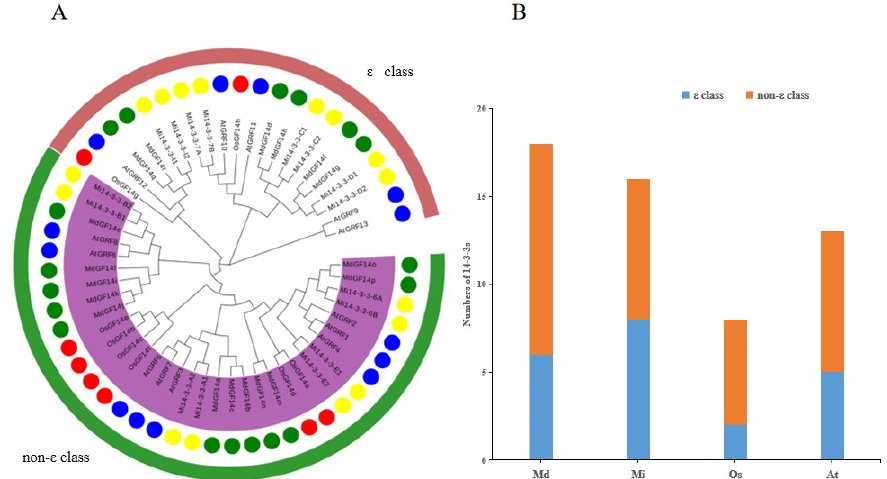
Figure 5. Phylogenetic analysis of 14-3-3 genes in Mangifera indica L., Arabidopsis thaliana , Oryza sativa , and Malus domestica . ( A ) The phylogenetic tree depicts the relationships among 16 Mi14-3-3 (yellow circles), 8 OsGF14 (red circles), 18 MdGF14 (green circles) and 13 AtGRF (blue circles) genes. The rootless tree was constructed using the LG model of MEGA 11.0 and divided into two subfamilies. The different groups are marked with differently coloured branches, and the different background colours indicate the various 14-3-3 gene types. ( B ) Statistical analysis results for 14-3-3 members from apple (Md), mango (Mi), rice (Os) and Arabidopsis (At).